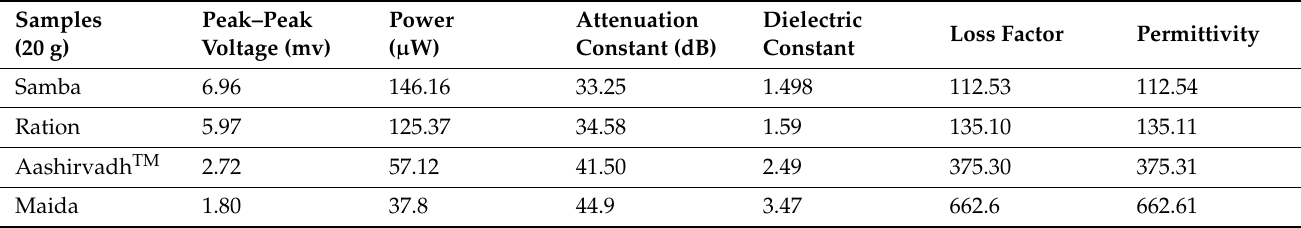
Table 3. Electrical parameters of different varieties of wheat flours. Samples